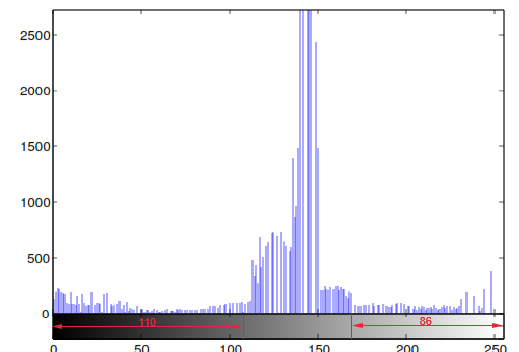
Figure 5. Results of applying local histogram equalization on initial intervals by algorithm 1 on Figure 9a.